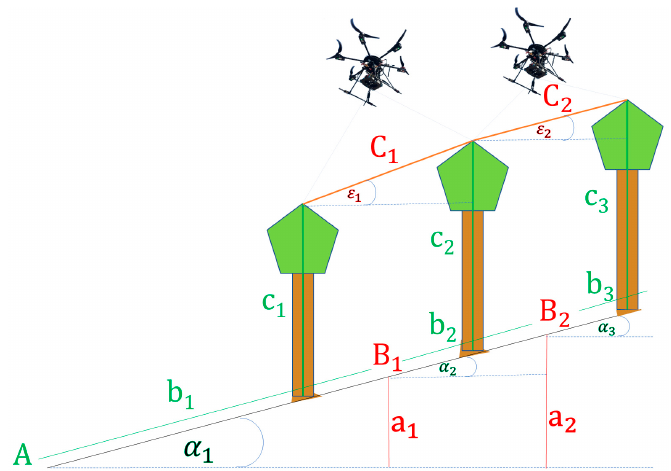
Figure A1. Real flying altitude above starting point measured by UAV on-board computer (A), above ground (B), and above crown (C): distance to rocks (a), slope angle ( α ), distance between the lines (b), tree height (c), angle and slope between two tree crowns ( ε ). All in-field measurements are in green and the calculated values are in red. The real FA above ground (B) is calculated by using the FA from the starting point (A) minus the distance to rocks ( a ):